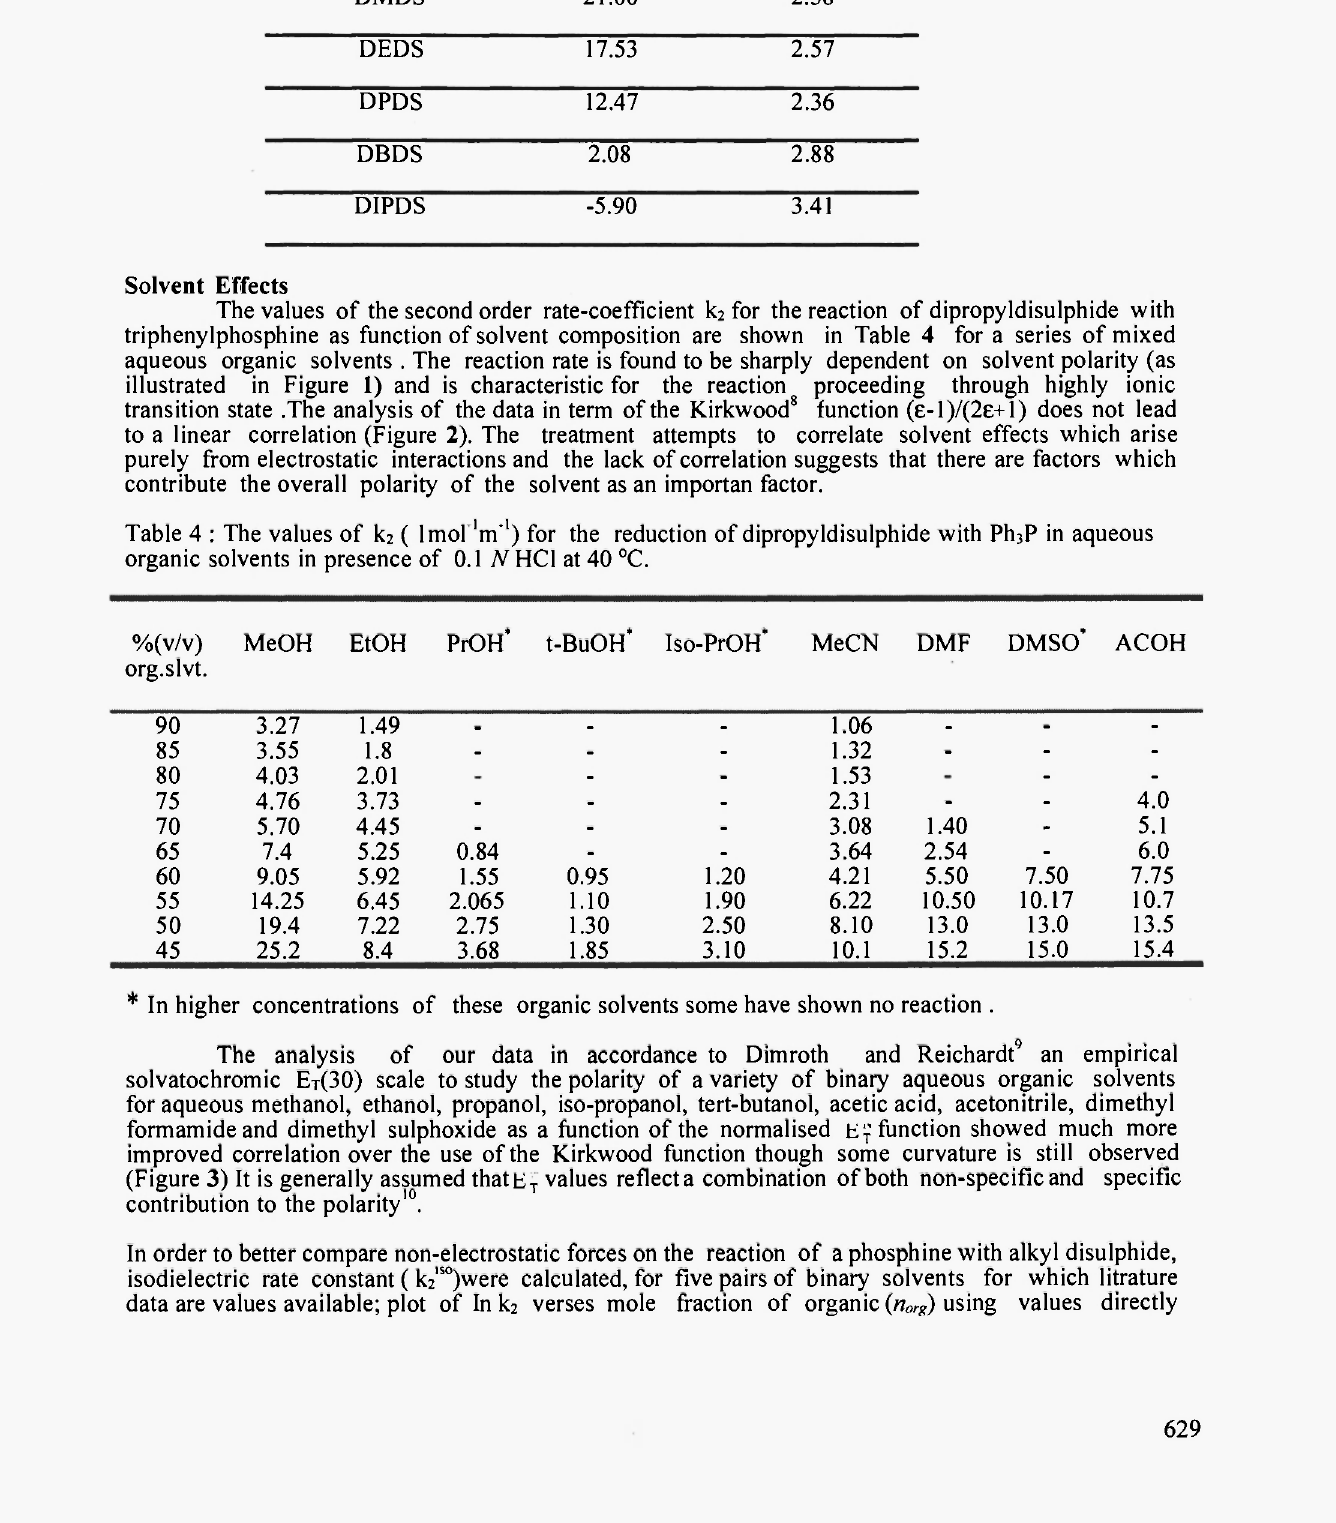
Table 3: Arrehenius parameters the reduction of alky 1 disulphides